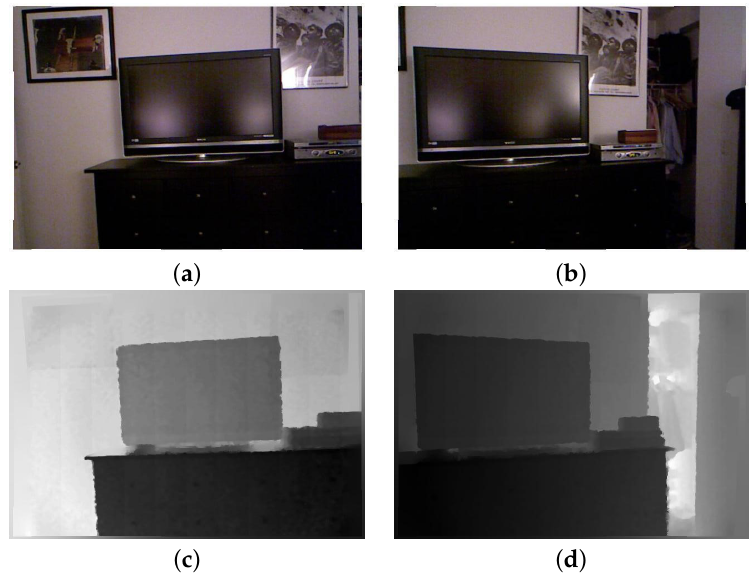
Figure 10. The RGB image of the sixth pair and their depth images: ( a ) original RGB image numbered 191; ( b ) original RGB image numbered 192; ( c ) depth image of ( a ); ( d ) depth image of ( b ).